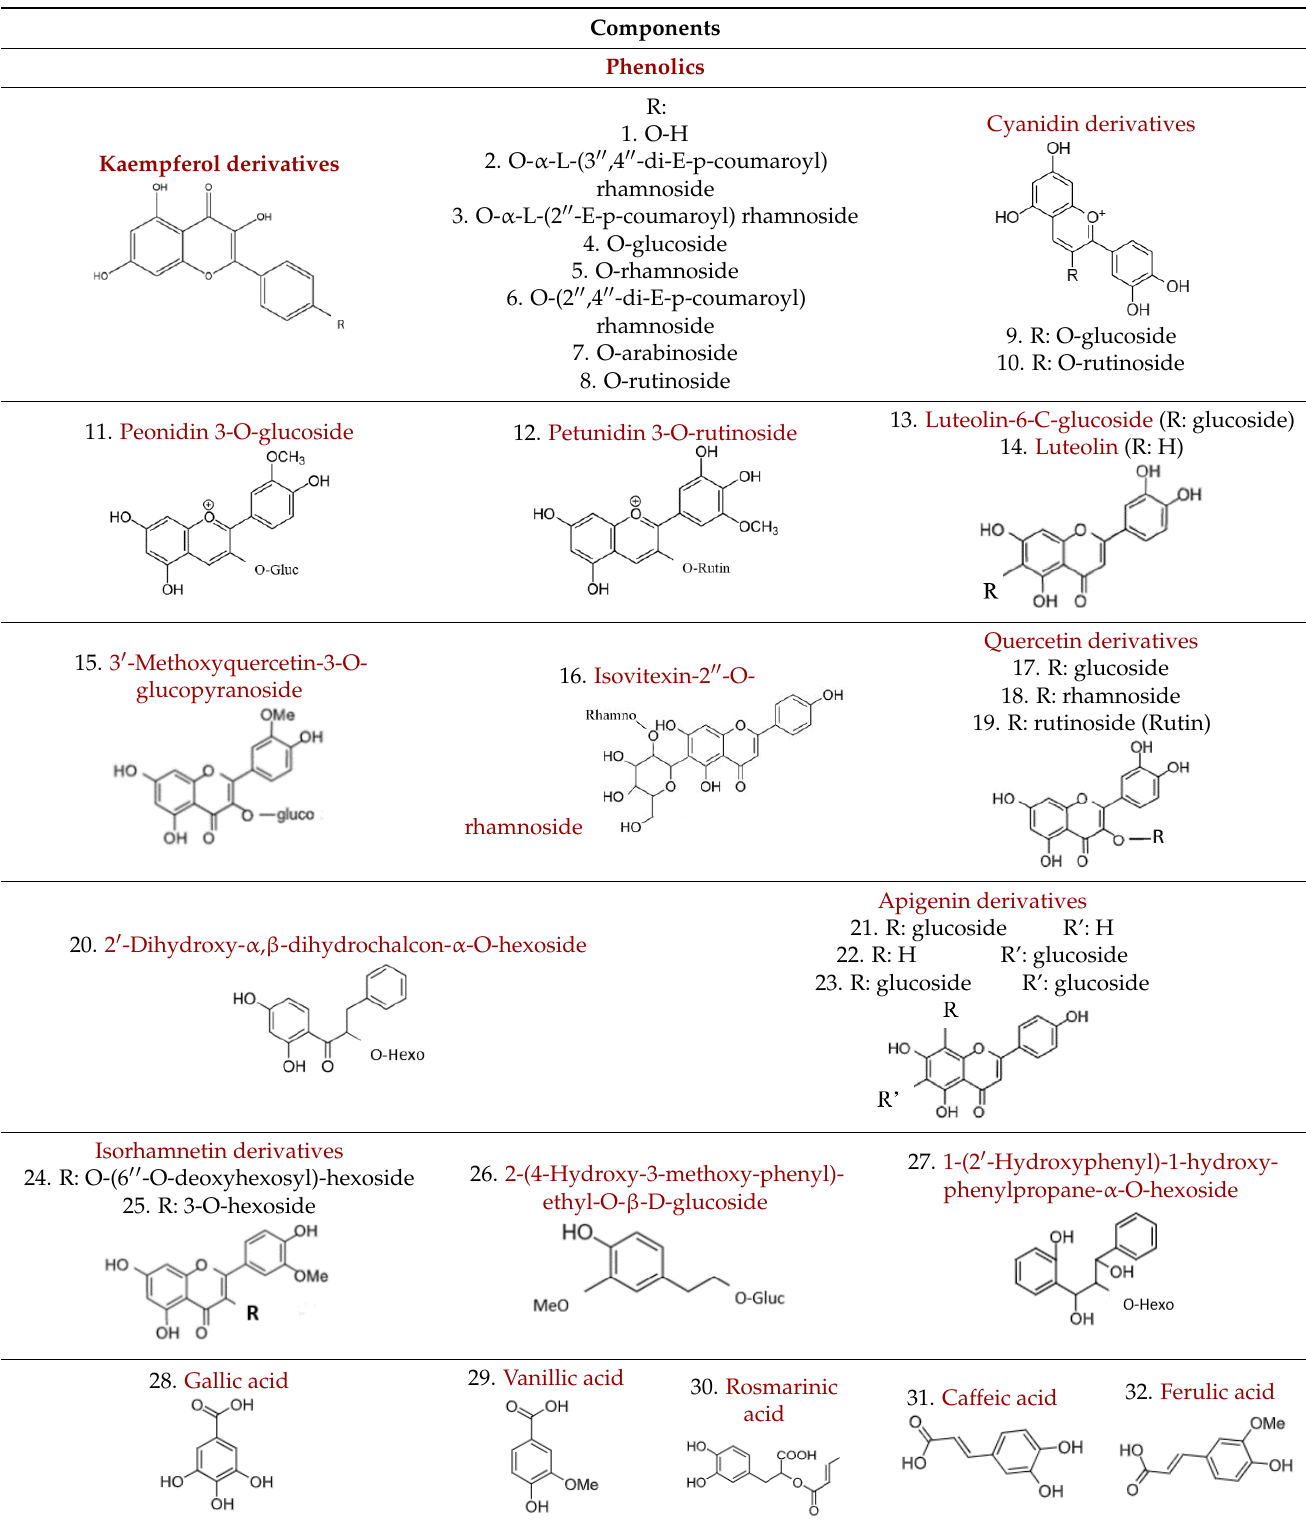
Table 2. Components of leaves, fruits, essential and fixed oil of L. nobilis.